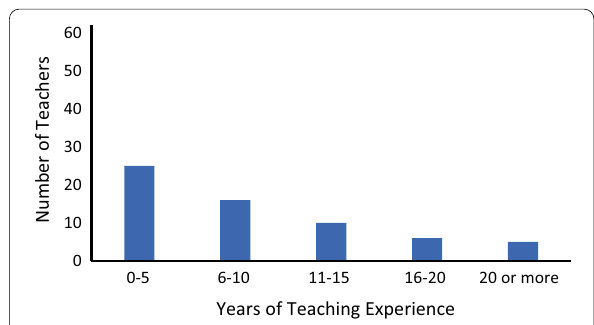
Fig. 1 Distribution of teachers across years of teaching experience